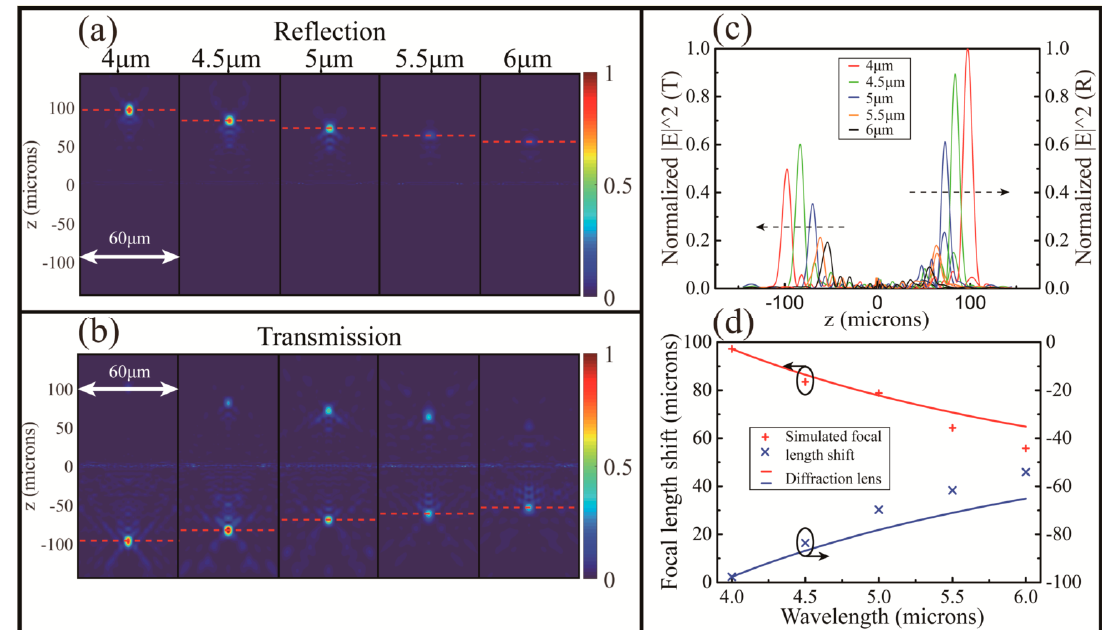
Figure 6. ( a ), ( b ) Normalized electric field intensity in the xz -plane under different incident Figure 6. ( a , b ) Normalized electric field intensity in the xz -plane under di ff erent incident wavelengths wavelengths ranging from 4 μ M to 6 μ M for MDLs with reflection and transmission, respectively. ( c ) ranging from 4 µ M to 6 µ M for MDLs with reflection and transmission, respectively. ( c ) Normalized Normalized distribution of electric field intensity of different incident wavelengths on the distribution of electric field intensity of di ff erent incident wavelengths on the propagation plane ( x = 0). propagation plane ( x = 0). ( d ) Simulated positions of focal (symbols) for MDLs with reflection and ( d ) Simulated positions of focal (symbols) for MDLs with reflection and transmission compared to transmission compared to conventional diffraction lens (lines) at different wavelengths in infrared conventional di ff raction lens (lines) at di ff erent wavelengths in infrared spectrum.